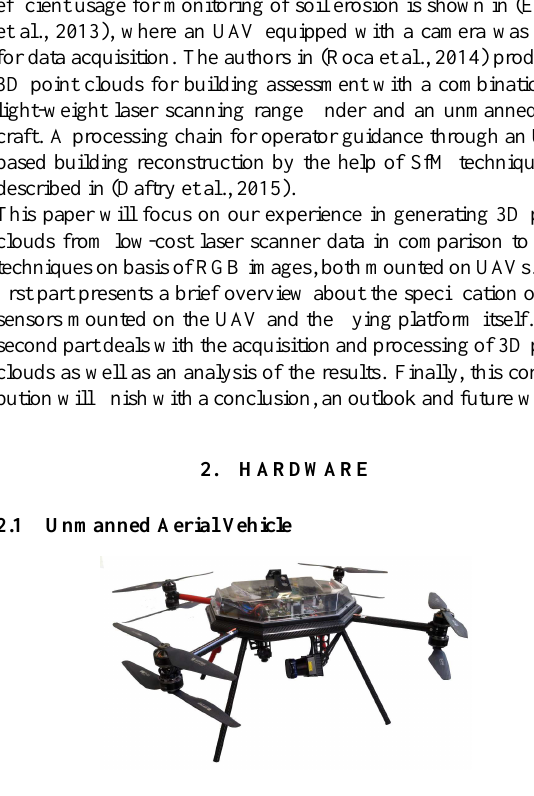
Figure 1: UAV Cadmic Goliath Coax 8